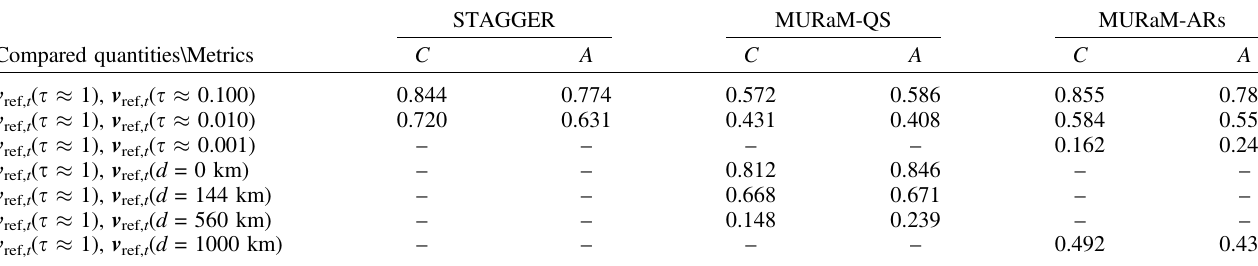
Table 1. Similarity between the reference velocity fi eld at the surface v ref ( s (cid:2) 1) and at various optical and geometrical depth above and below the surface, s and d , respectively. Metrics C and A correspond to the correlation coef fi cient (Eq. (4)) and the spatially-averaged normalized dot product A (Eq. (5)), respectively, averaged over time.